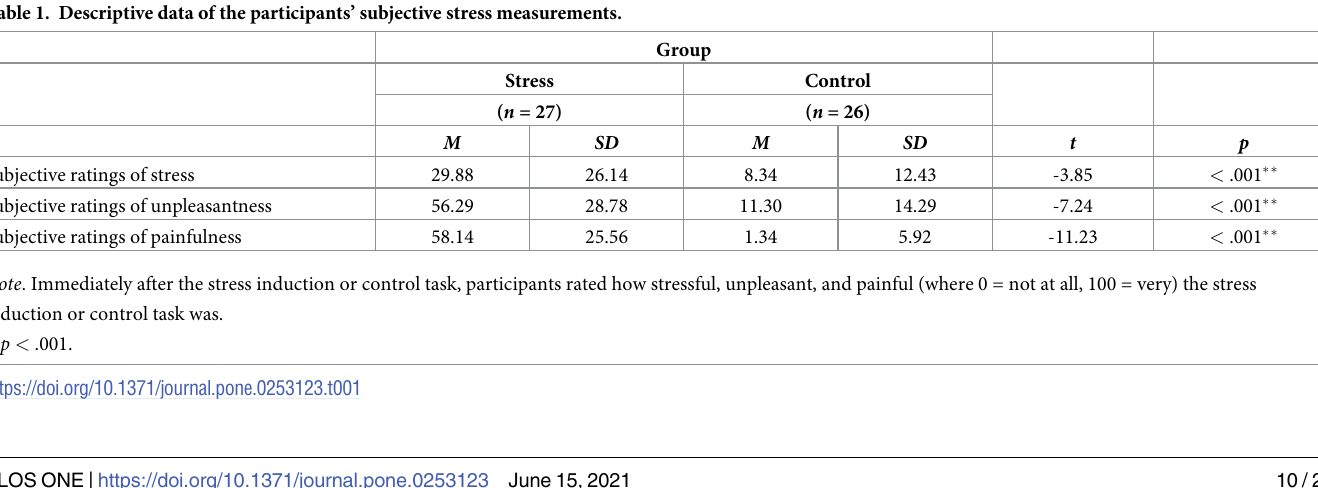
contraceptives and of those who do not use them did not differ significantly ( t (17) = 0.35, p = ( t (11) = -0.46, p = .65).